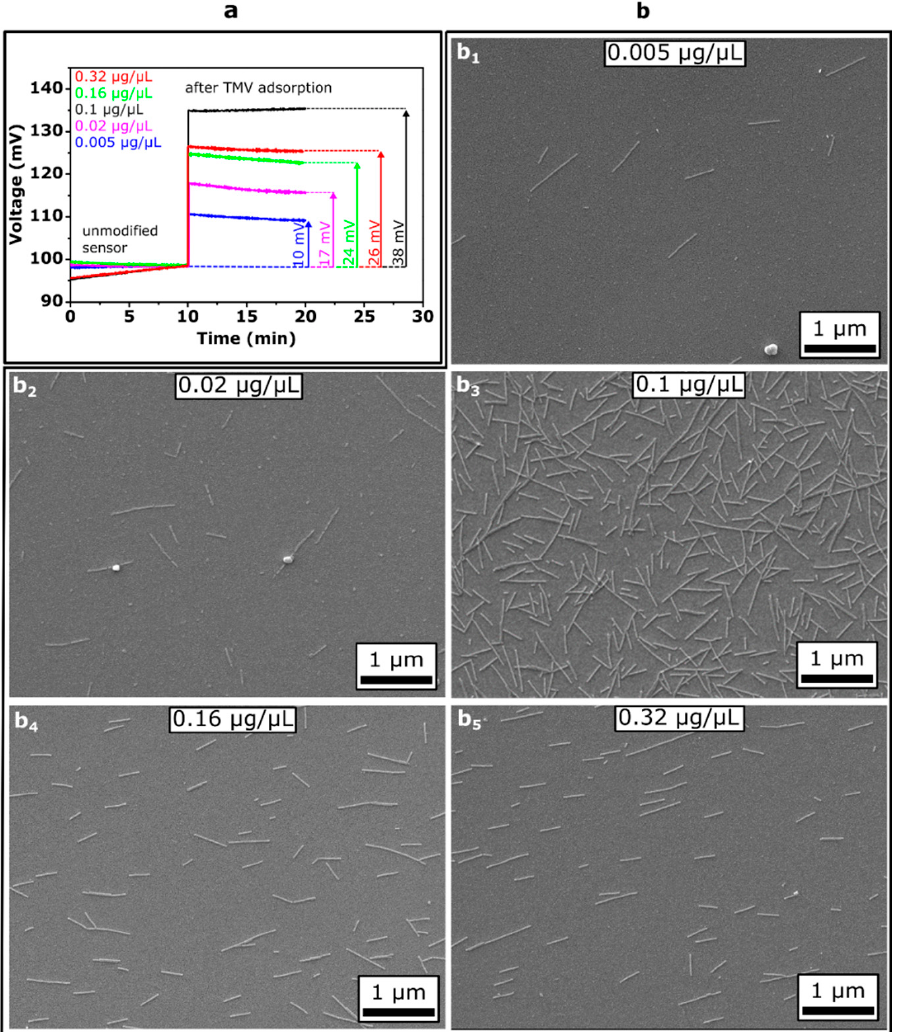
Figure 4. ( a ) ConCap responses of EIS sensors before and after loading of TMV Cys-Bio particles from virus suspensions with different concentrations and ( b ) corresponding SEM images ( b 1 – b 5 ); incubation time for all experiments was 1 h.